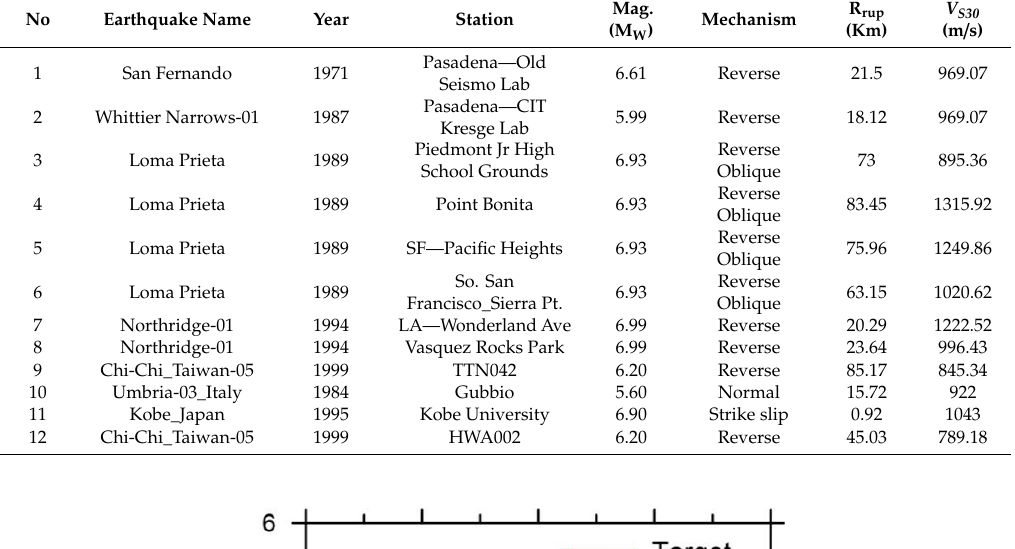
Table 5. Selected earthquake events.